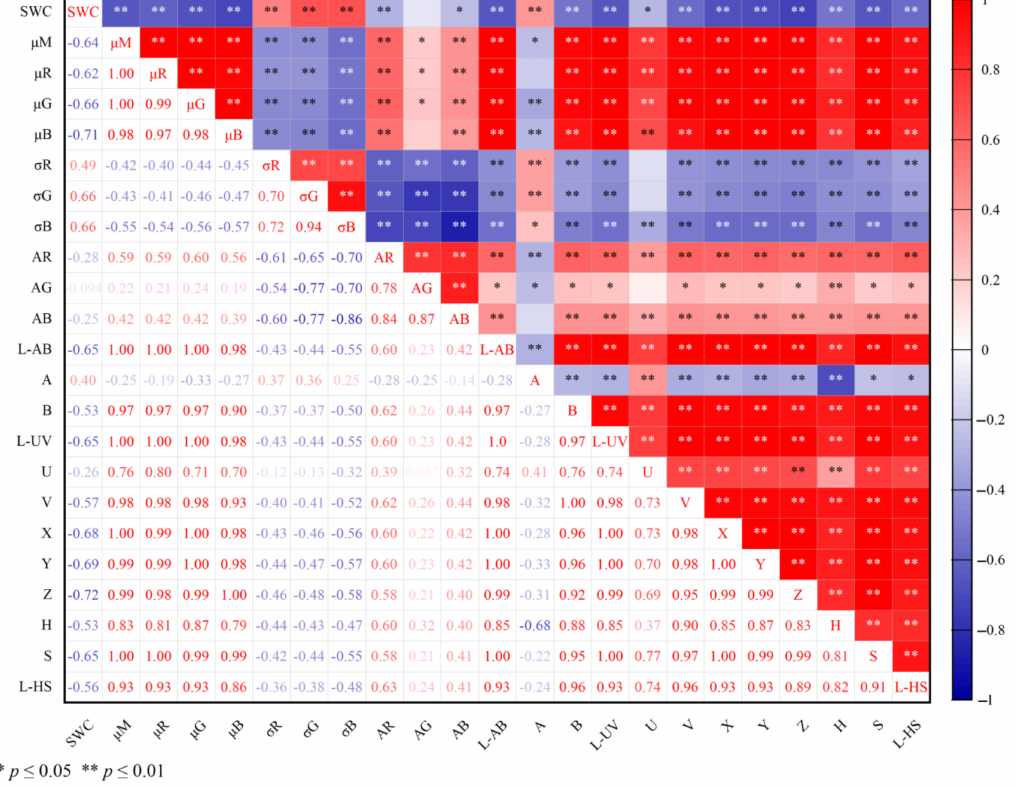
Figure 14. Correlation coefficient matrix between characteristic parameters and overall SWC (* and ** indicate significance at the 0.05, 0.01 level respectively; the colored numbers indicate the correlation coefficient between any two characteristic parameters; negative correlation is shown by the blue color, whereas positive correlation is indicated by the red color).